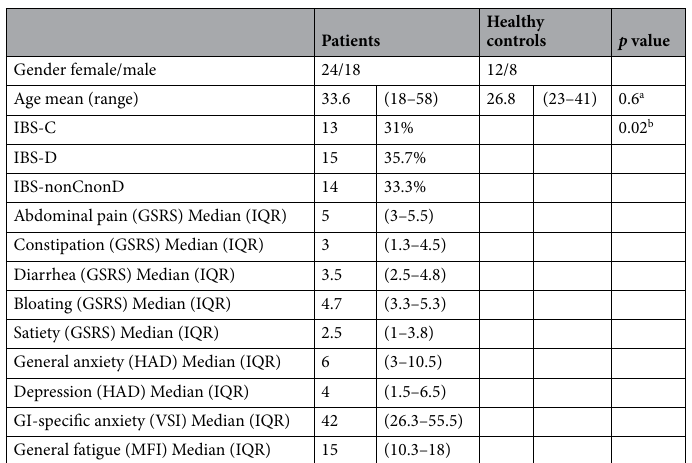
Table 1. Demographics, Rome III subtypes and symptom severity. GSRS: gastrointestinal symptom rating scale. HAD: Hospital anxiety and depression scale. VSI: Visceral sensitivity index. MFI: multidimensional